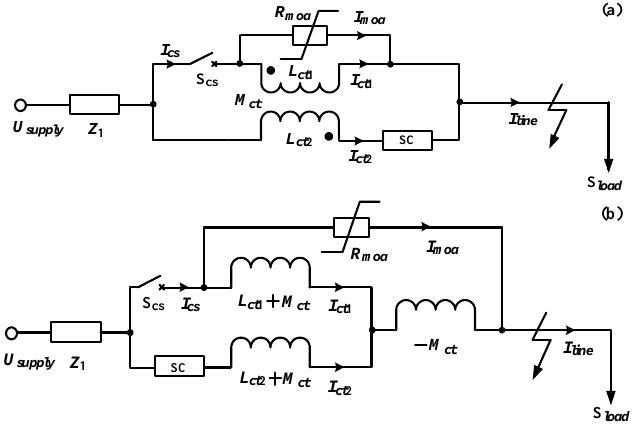
Figure 3. Schematic structure of the suggested flux-coupling-type SFCL. ( a ) Main connection and ( b ) electrical equivalent circuit. CS: controlled switch; CT: coupling transformer; SC: superconducting coil; and MOA: metal oxide arrester.